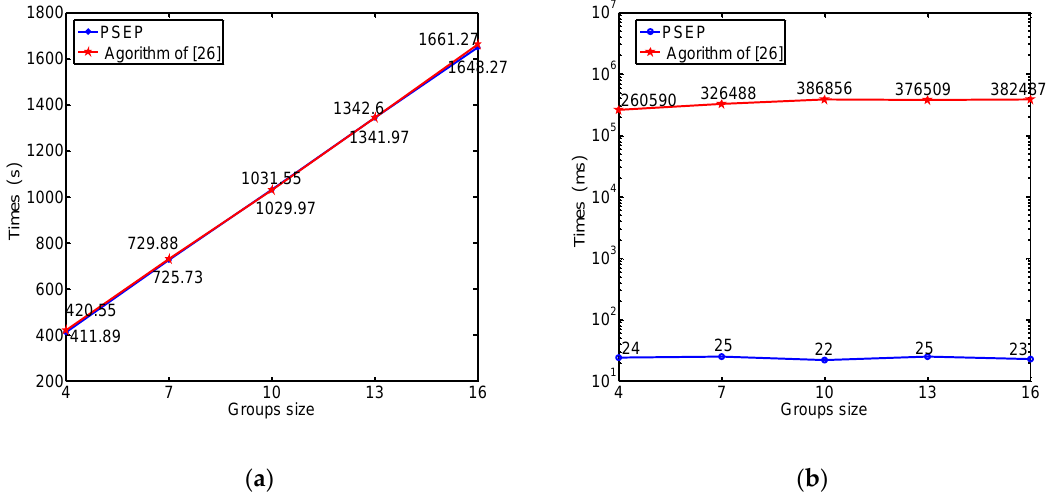
Figure 19. The comparative results when the group size is random. ( a ) The change of the total evacuation time with the increasement of the number of groups; ( b ) The change of the operation time with the increasement of the number of groups.